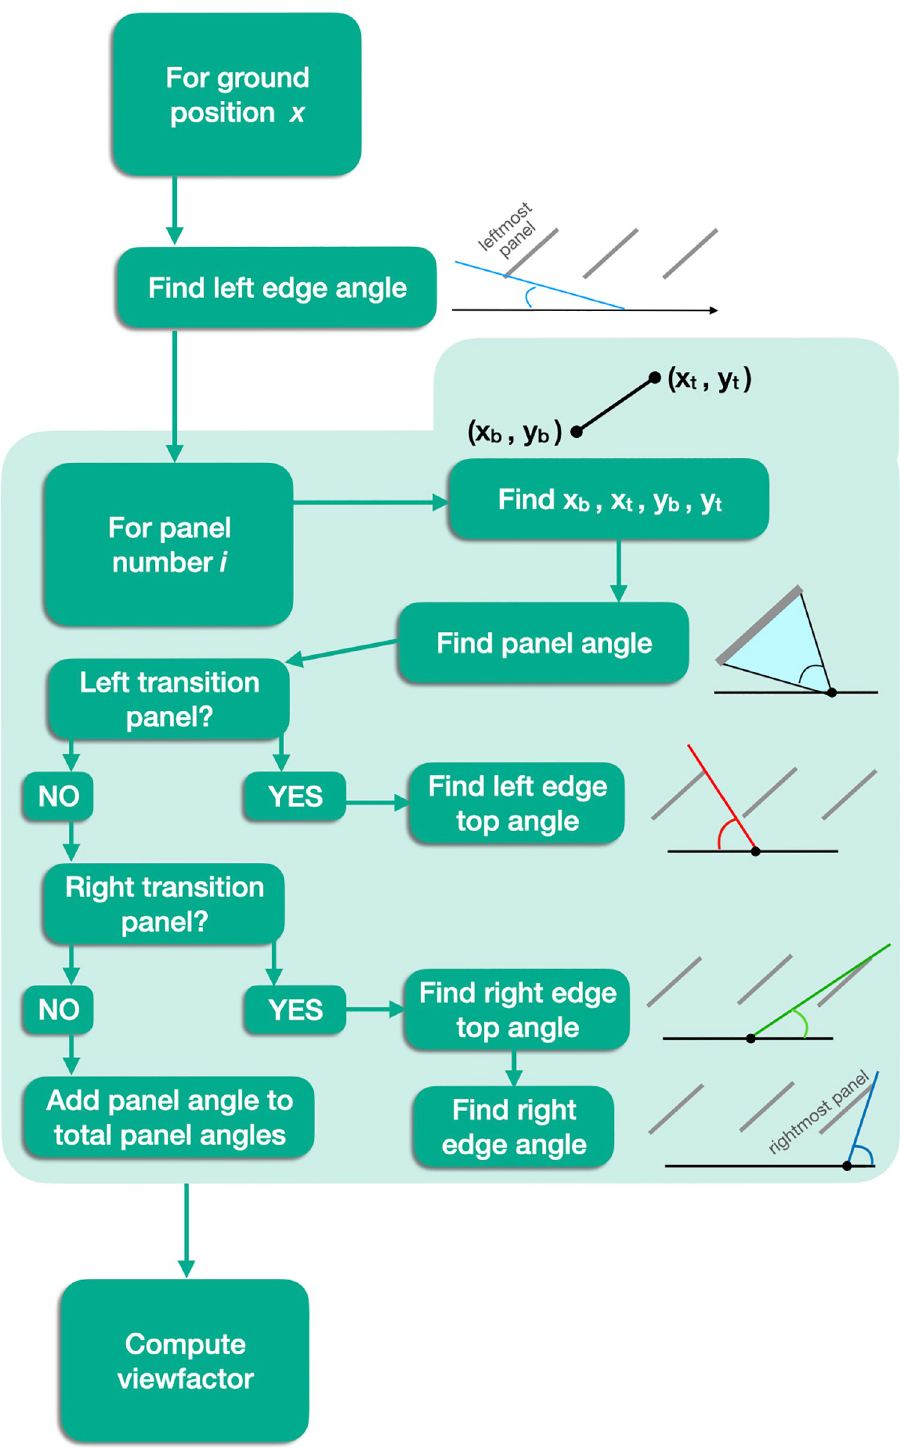
Fig 5. Computing the view